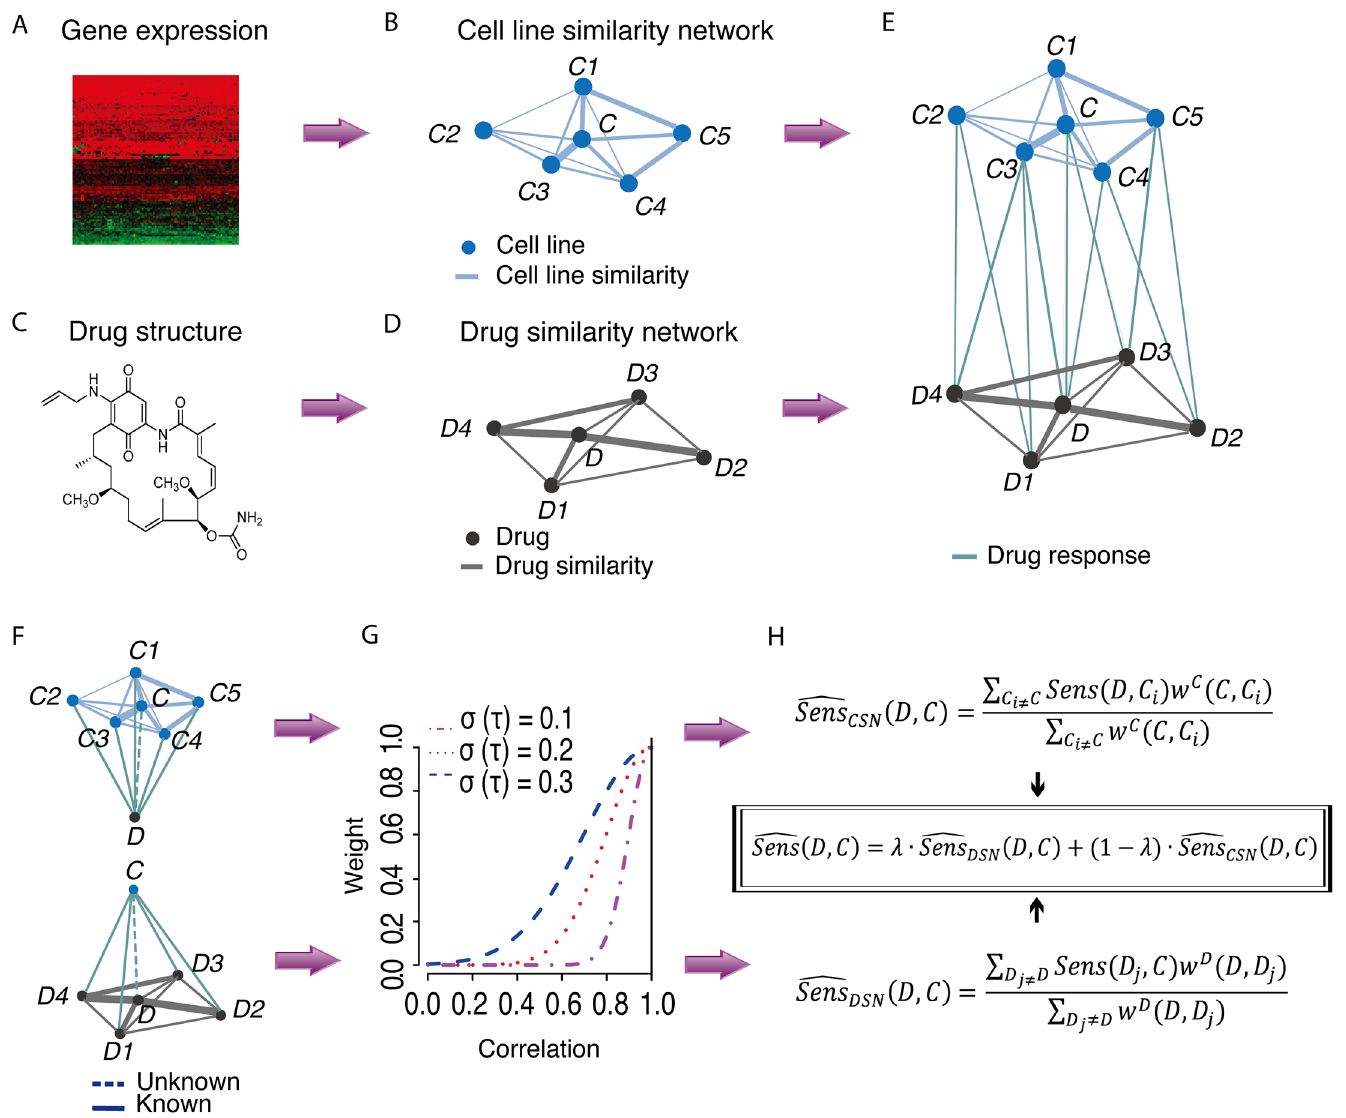
Fig 2. Computation framework. (A – E) Construction of the dual-layer integrated cell line-drug network model. (F – H) Drug sensitivity predictions based on information from the integrated cell line-drug network. (F) Two sub-networks for predicting the response of cell line C to drug D . (G) For each sub-network, the weighted arithmetic mean was used to measure an unknown drug-cell line response based on their neighboring cell lines or drugs. (H) Predictions from each of the two individual sub-networks were merged using a weighted model to determine the final